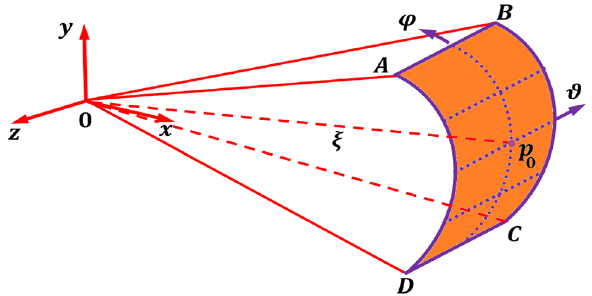
Figure 3. Discretized model of the acoustic far-field spherical bounded domain with a far-field point p 0